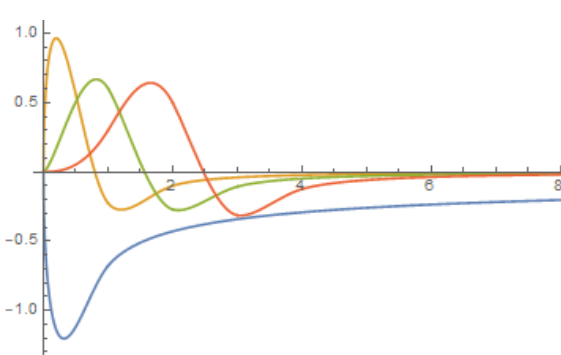
Figure 5. The fractional derivatives C D t N 03 (blue), C D t N 13 (orange), C D t N 23 (green), C D t B 3